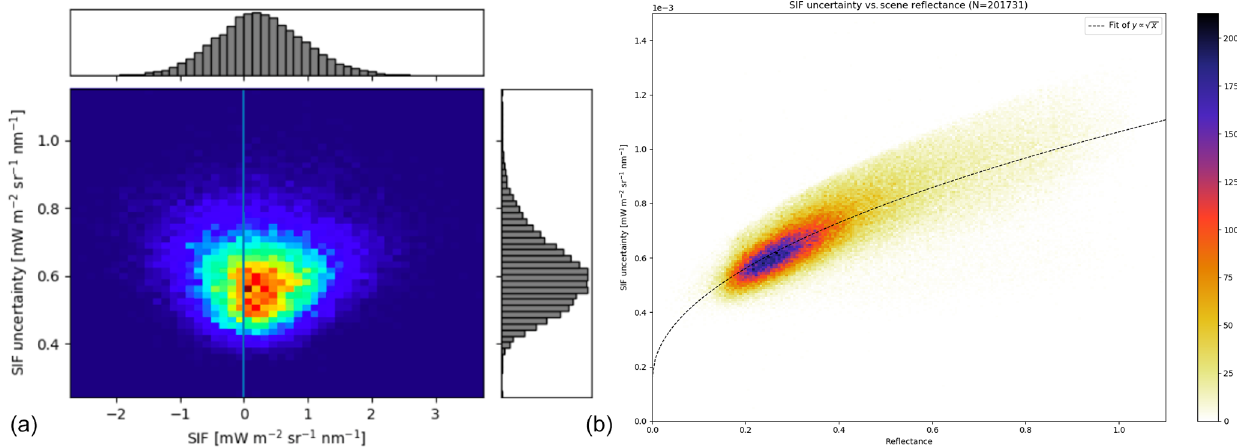
Figure 7. (a) Uncertainties in GOME-2A fluorescence retrievals as a function of signal strength on 1 August 2012. Only pixels over land (FRESCO + albedo (at 758nm ) > 0 . 08) with cloud fractions < 0 . 4 have been selected. The colours indicate the number of occurrences of combinations of SIF and SIF uncertainty values. (b) SIF uncertainties as a function of scene reflectance for August